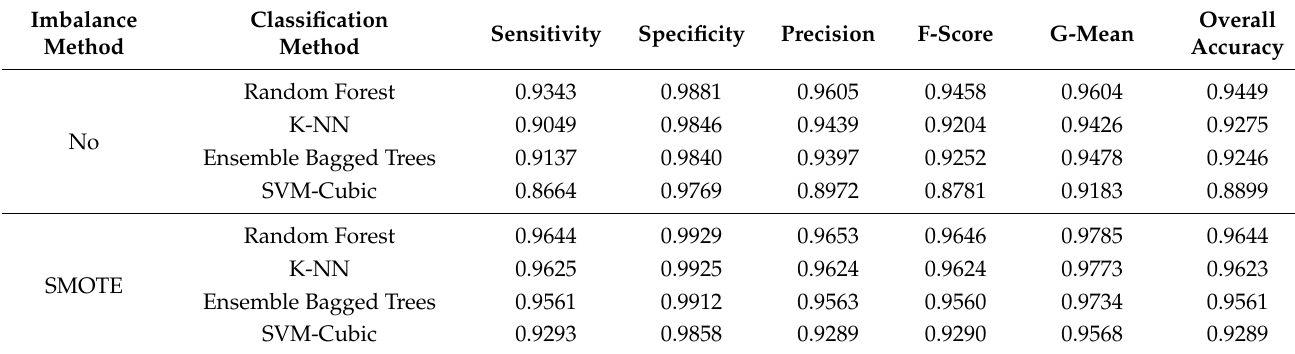
Table 7. Classification Results.